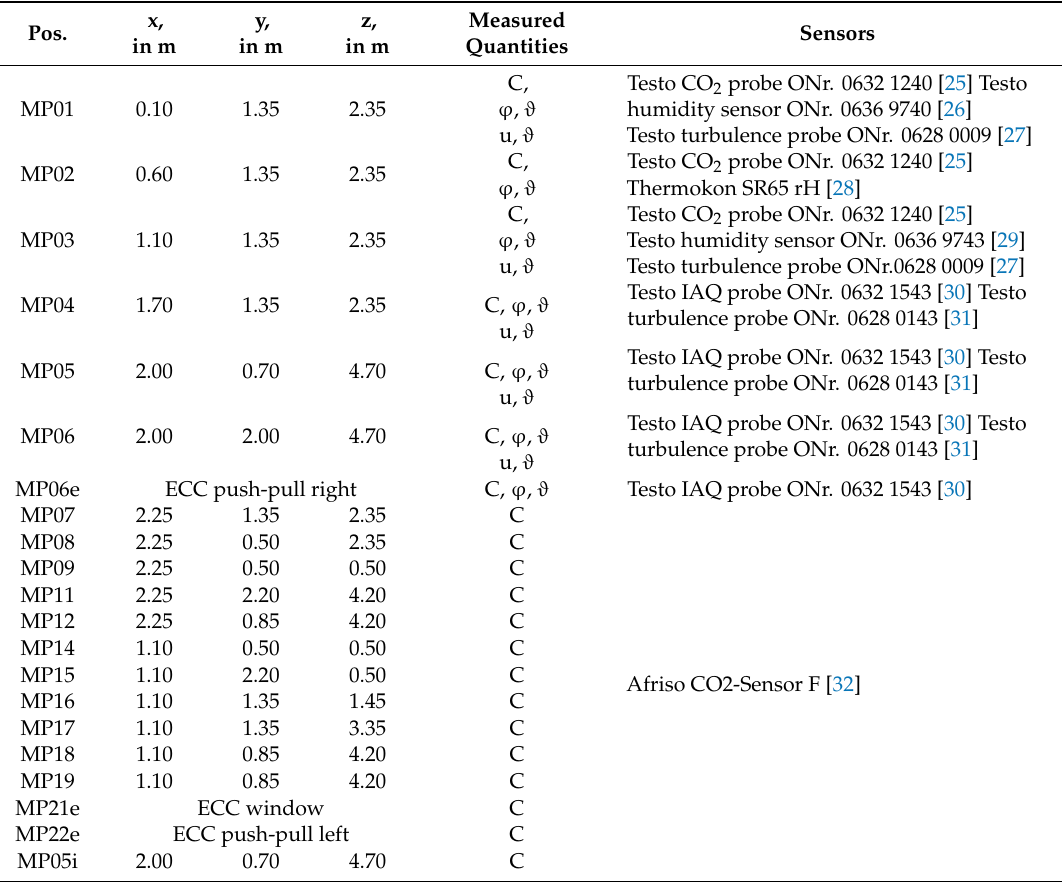
Table 6. Sensor positions, uncertainties and